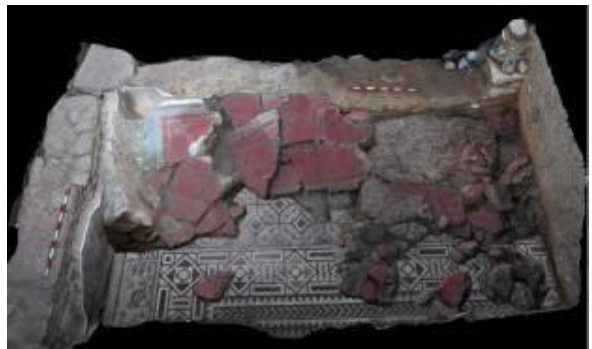
Figure 1. Collapse of the wall coverings in the Sala del Mosaico de los Amores (López Rodriguez,